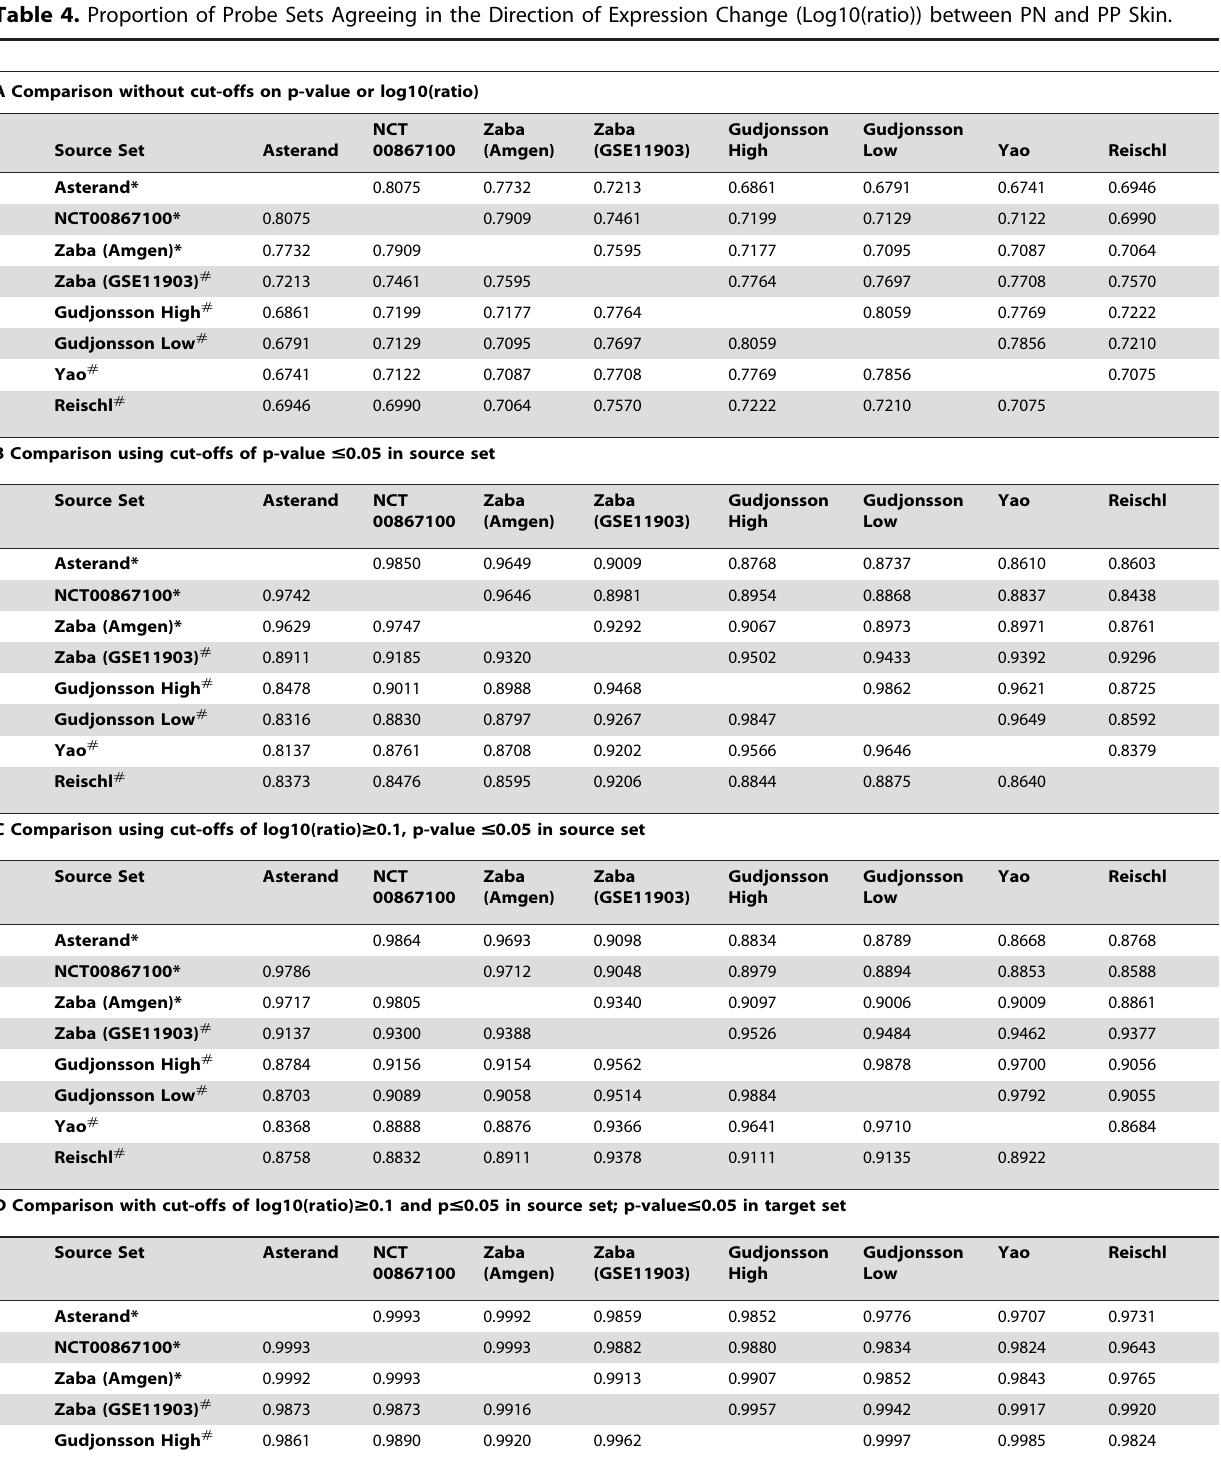
Table 4. Proportion of Probe Sets Agreeing in the Direction of Expression Change (Log10(ratio)) between PN and PP Skin.